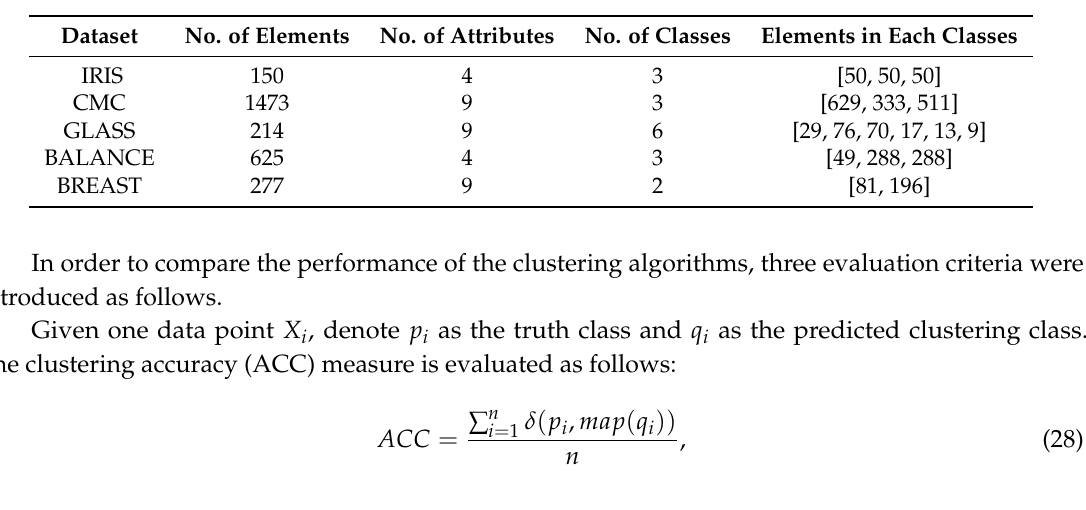
Table 1. Description of the experimental